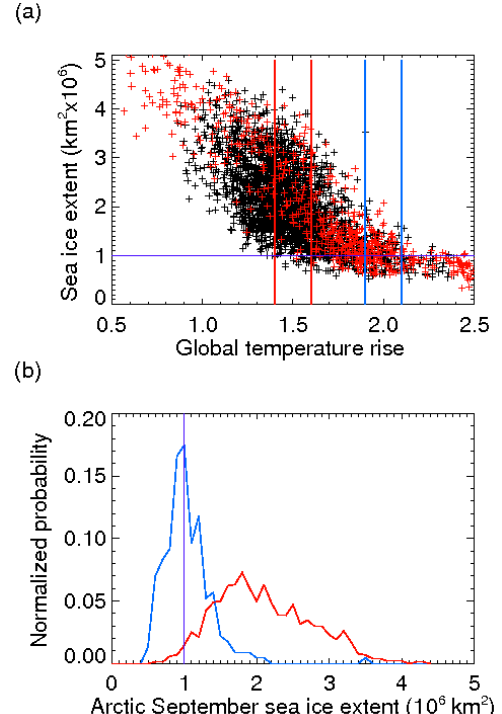
Figure 3. (a) All 48 ensemble members are combined to derive a September ice extent vs. global temperature scatter plot (black symbols) with the complete four-member RCP2.6 and four-member RCP4.5 simulations included (red symbols). The threshold of 1 mil- lionkm 2 signifying an almost ice-free Arctic is shown with the pur- ple horizontal line. The data points used to evaluate the probability distribution function of (b) are selected from the global temperature thresholds of 1 . 5 ± 0 . 1 ◦ C (red vertical lines) and 2 . 0 ± 0 . 1 ◦ C (blue vertical lines). (b) The normalized probability distribution functions of Arctic sea ice extent at global temperature rises of 1 . 5 ± 0 . 1 ◦ C (red) and 2 . 0 ± 0 . 1 ◦ C (blue) are associated with the ensemble mem- bers shown in (a) . The 1 millionkm 2 threshold for an ice-free Arctic is indicated by the purple vertical